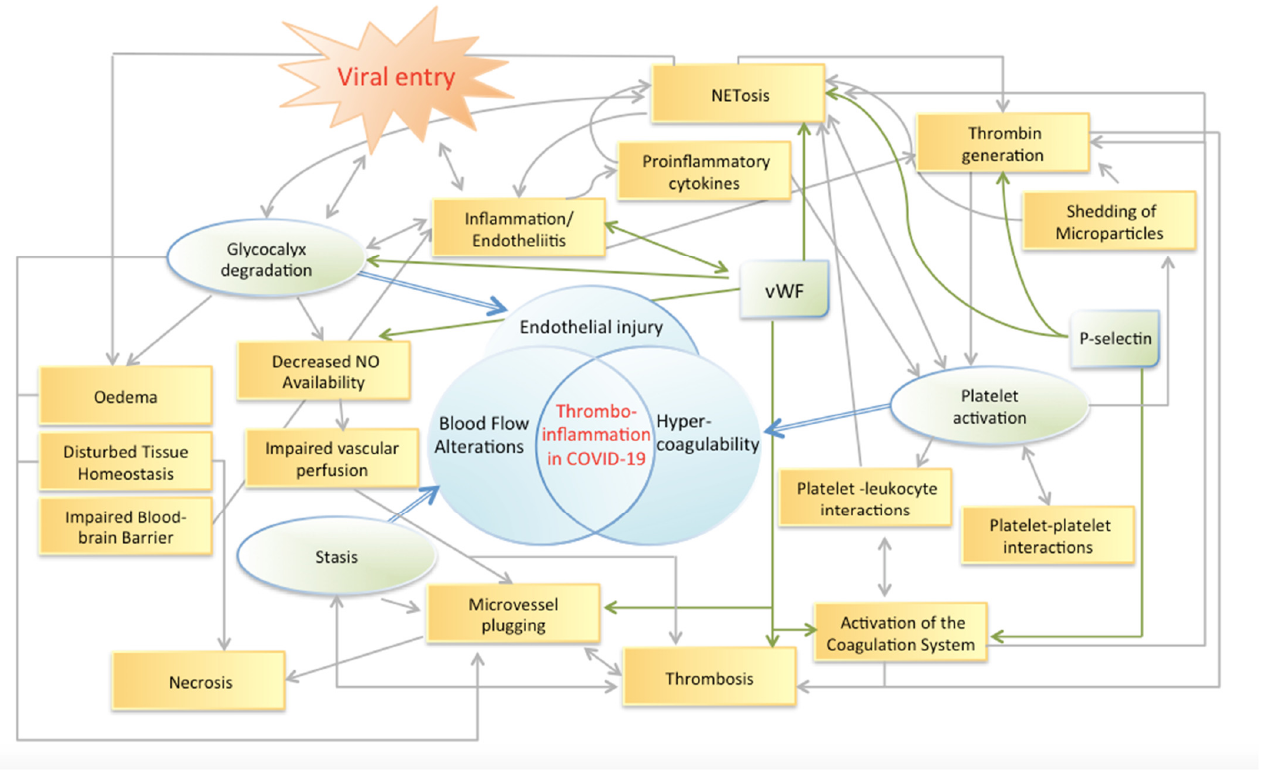
Figure 1. Endothelial dysfunction with glycocalyx degradation is postulated as the central mechanism induced through and facilitating viral entry. The resulting inflammatory and procoagulative processes initiate a complex cascade destabilizing the equilibrium of Virchow’s triad resulting in (micro-) thrombosis and tissue necrosis. The concept of the figure is modified after Ataga et al.—‘Hypercoagulability and thrombotic complications in hemolytic anemias.’ [23]. Endothelial cell damage due to the viral infection results in subendothelial collagen exposure initiating von Willebrand factor (vWF) binding via its A3 domain [24,25]. This promotes platelet adhesion via the glycoprotein (GP) Ib-V-IX complex, leading to platelet are discussed later in the text) [26–28]. Platelet activation can be propagated by several